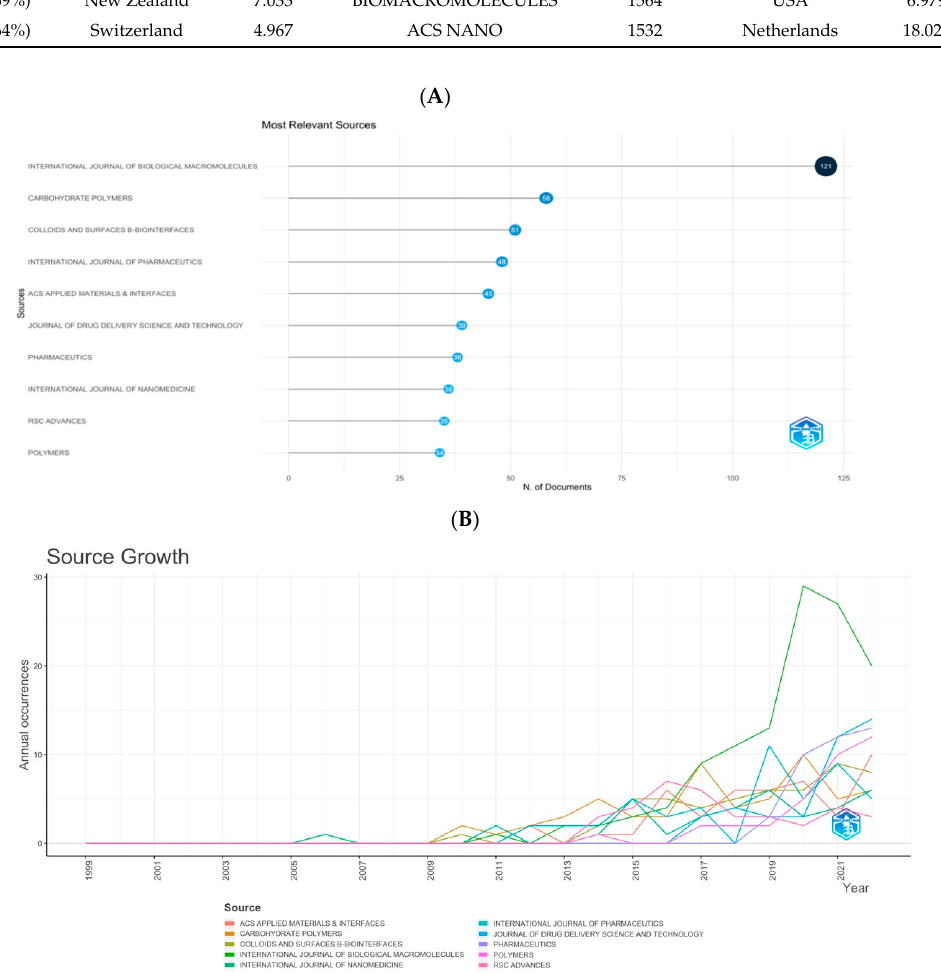
Figure 3. ( A ) The top 10 journals with the most publications generated by R-Bib liometrix. ( B ) Annual occurrences of the top 10 journals with the most publications generated by R-Bibliometrix. The dual-map overlay of journals revealed the overall scientific contribution. As shown in Figure 4, the left side represents the map of citing journals, and the right side represents the map of the cited journals. The label describes the subject covered by the journal. Colored line paths represent citation relationships. All paths originate from the citing map and point to the cited map, indicating the citation tracks of knowledge and knowledge flow. For example, four main citation paths were shown in the current map, suggesting that the citing papers concerning NDSRSsin wound healing primarily focused on journals in molecular biology, immunology physics, materials, and chemistry. At the same time, most of the cited articles were published in environmental science, toxicology, nutrition, chemistry, materials, and physics journals. Figure 4. The dual-map overlay of journals related to NDSRSsin the wound healing field.